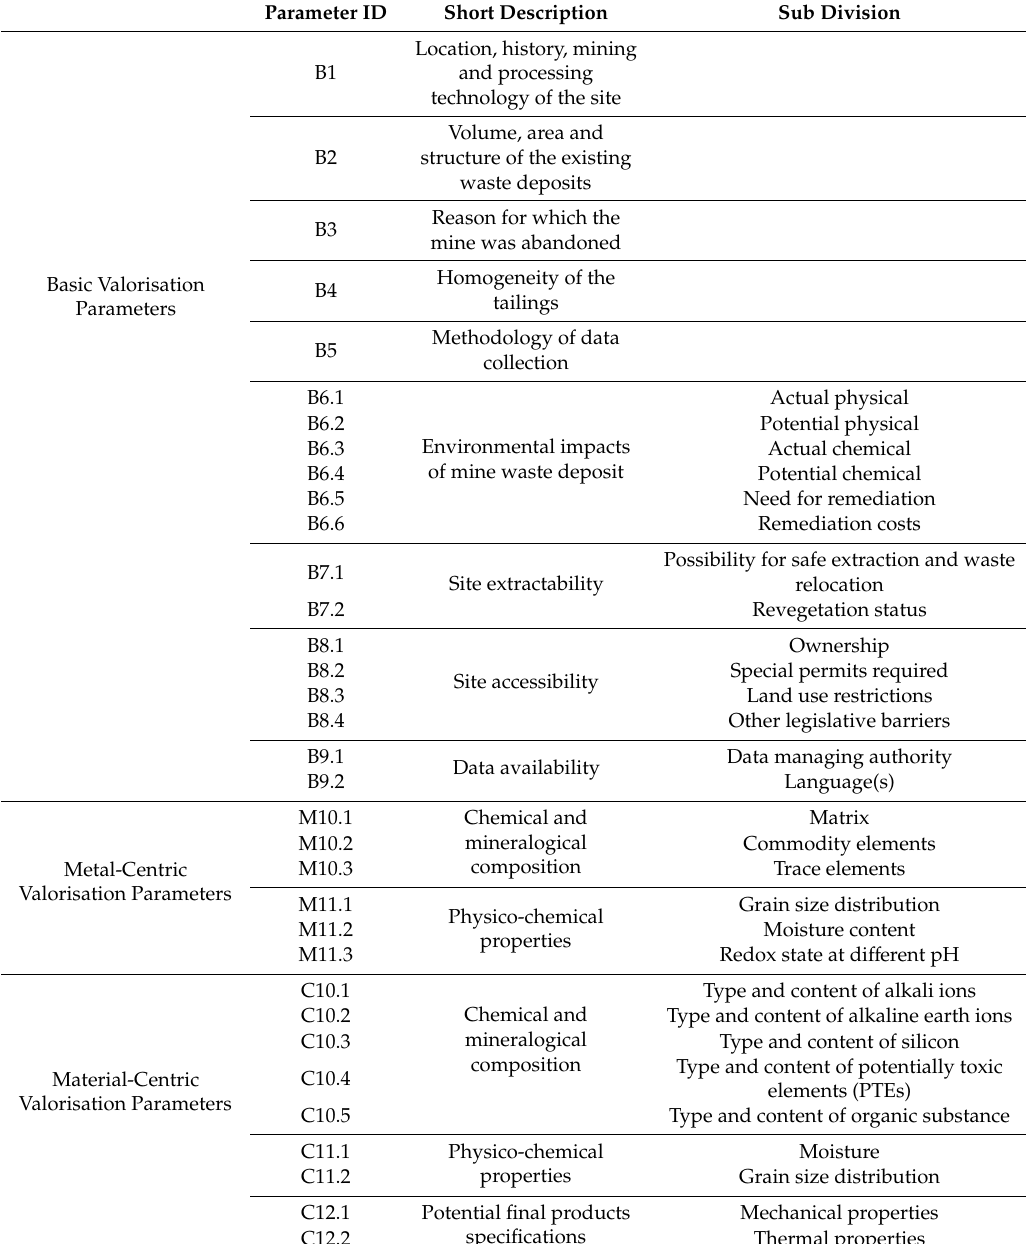
Table 2. Key identified mine waste valorisation